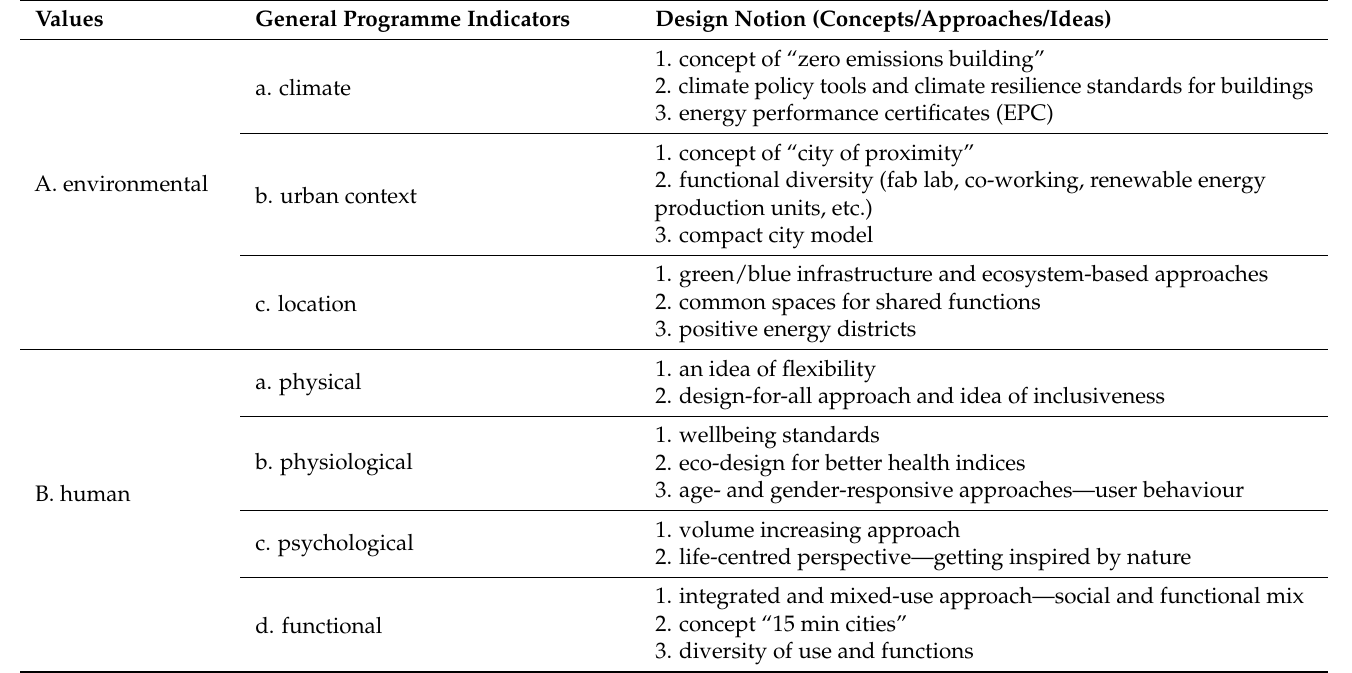
Table 2. Housing Programming Matrix based on the EU design